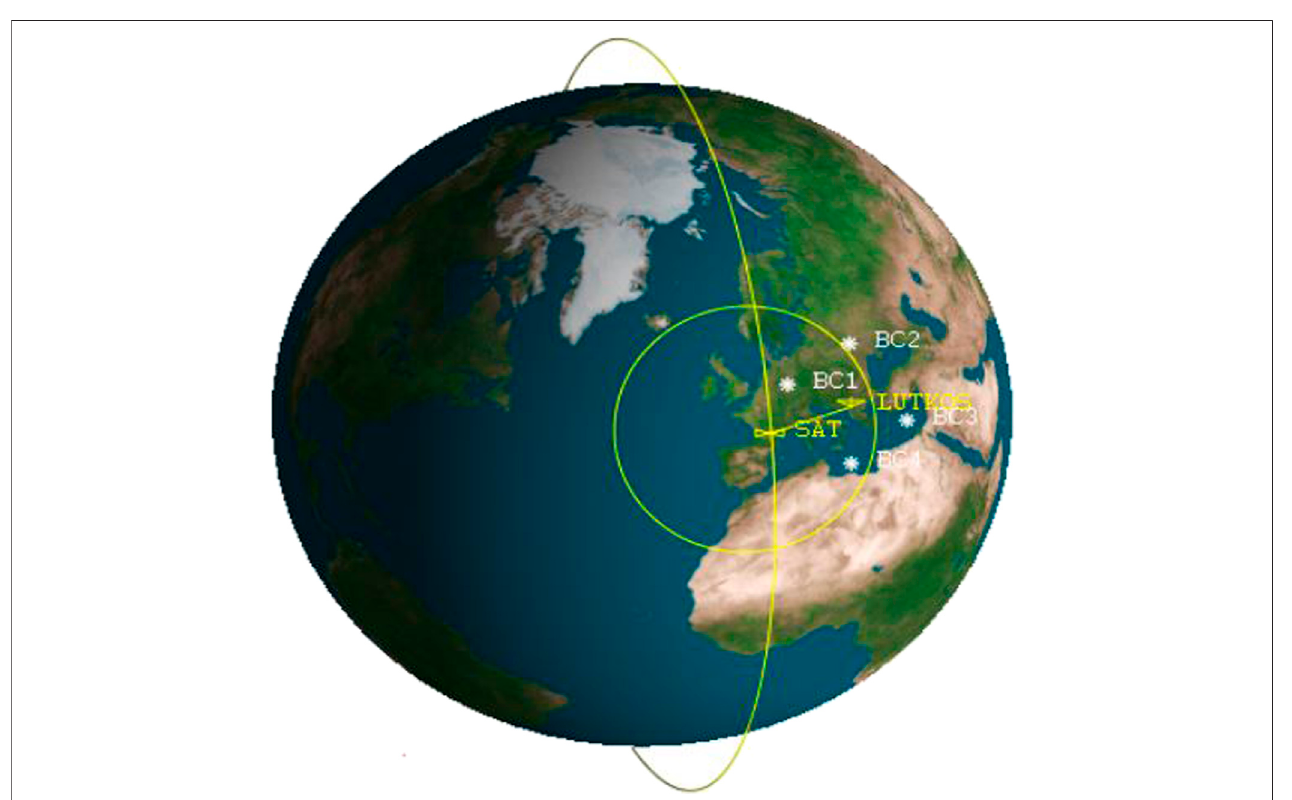
FIGURE 6 | Simulated LEO satellite ’ s coverage